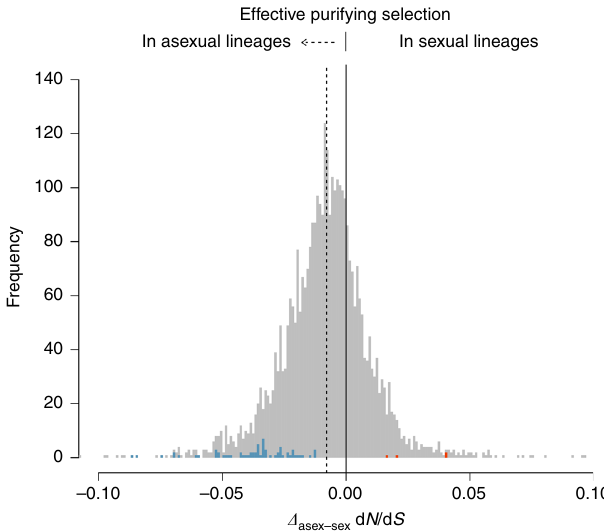
Fig. 2 Per-gene differences in d N /d S ratios between reproductive modes. The histogram shows the distribution of per-gene differences in d N /d S ratios between asexual and sexual terminal branches in a tree comprising three sexual and three asexual oribatid mite species for 3539 orthologous loci under purifying selection (d N /d S < 1). To improve data presentation, the histogram range is limited to − 0.1 to 0.1, representing 3539 out of 3545 orthologs. The distribution mean ( − 0.008; dotted line) is shifted to the left indicating overall lower d N /d S ratios at asexual as compared to sexual branches (Wilcoxon signed-rank test V = 4.84*10 6 , P < 0.001). Frequencies of genes with signi fi cantly lower d N /d S ratios at asexual as compared to sexual branches or sexual as compared to asexual branches are coloured blue and red,